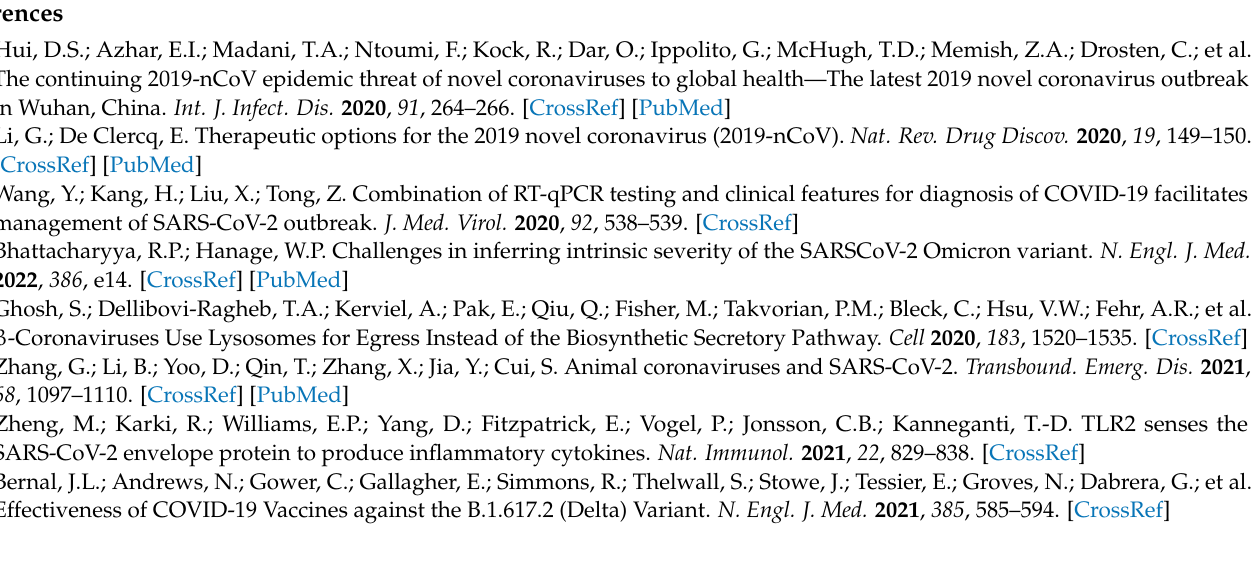
diagram. Figure S3. SEM image of mesoporous silica. Figure S4. 3D schematic diagram of RDV Figure S5. Powder X-ray diagram of solids MSN and MSN-NH2. Figure S6. The MSN-Au stability was tested and the result. Figure S7. The selectivity of N protein aptamer toward target. Figure S8. The concentration of RDV in PBS solution could be determined. Table S1. N protein aptamer and complementary chain. Table S2. Basic clinical features of the five volunteers. Table S3. Recovery results of N protein induced RDV signals in human blood samples ( n =